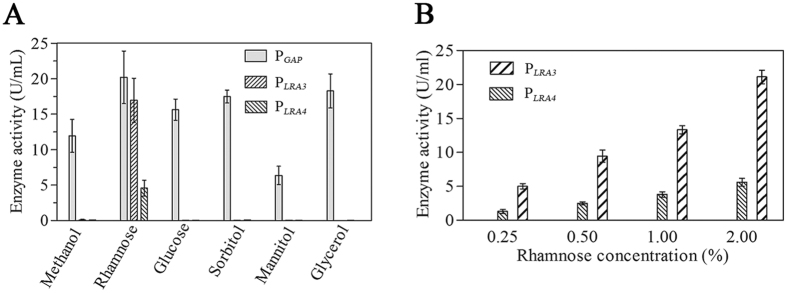
Expression profiles of β-galactosidase driven by PLRA3 and PLRA4 in the presence of different carbon sources (A) and various rhamnose concentrations (B).